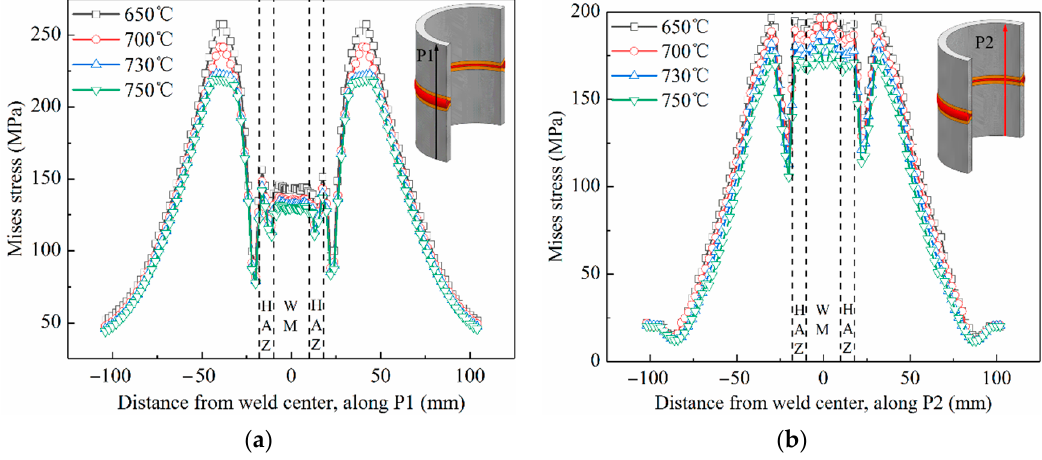
Figure 13. Mises stress distributions at different peak temperature along P1 path ( a ) and P2 path ( b ).